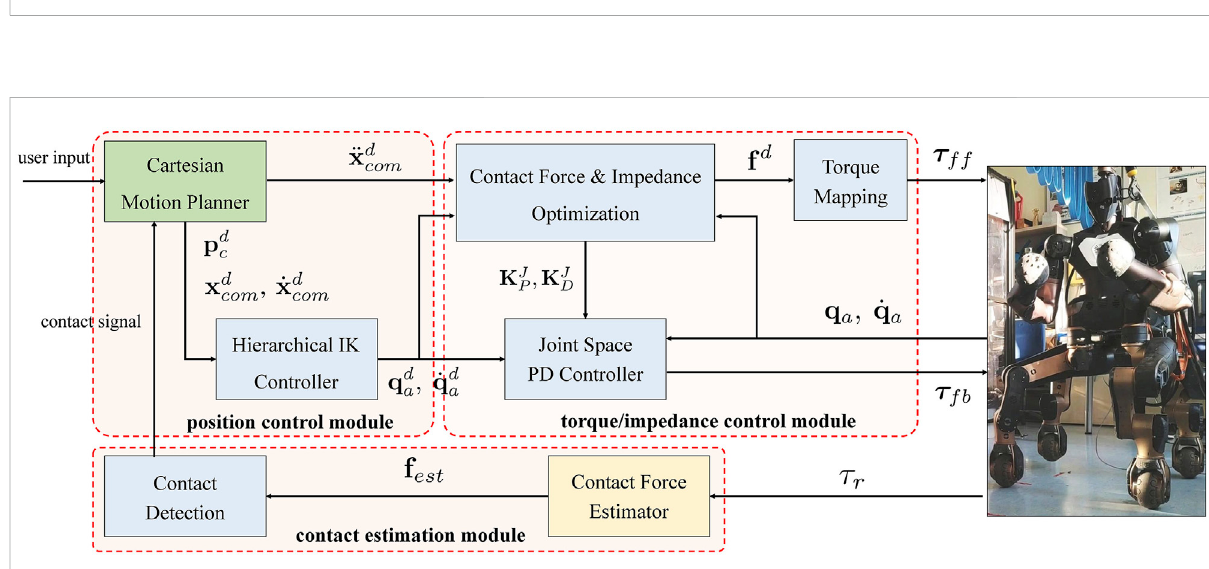
FIGURE 1 CENTAURO is a torque-controlled wheeled-legged quadruped robot designed in our lab (Humanoids and Human Centered Mechatronics, HHCM) at IIT. The world coordinate frame { W } is also displayed in the picture.